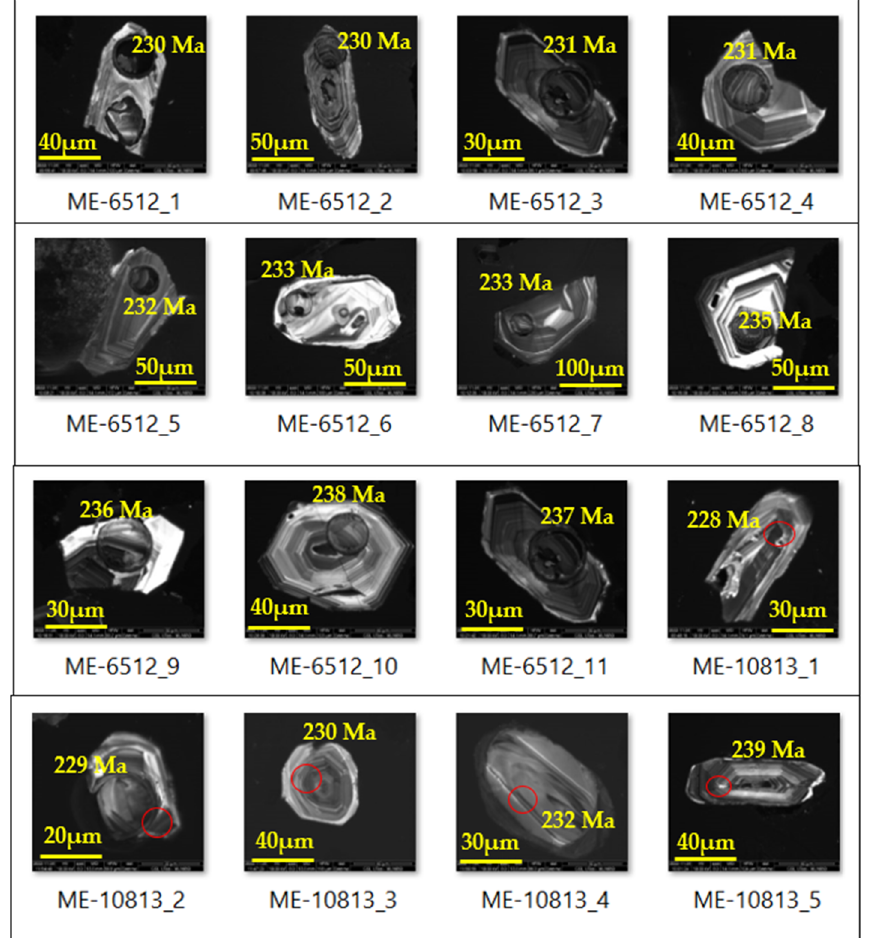
Figure 10. Cathodoluminescence (CL) images of zircon grains from the Semantan area, Malaysia. The round feature represents the position of the laser craters.